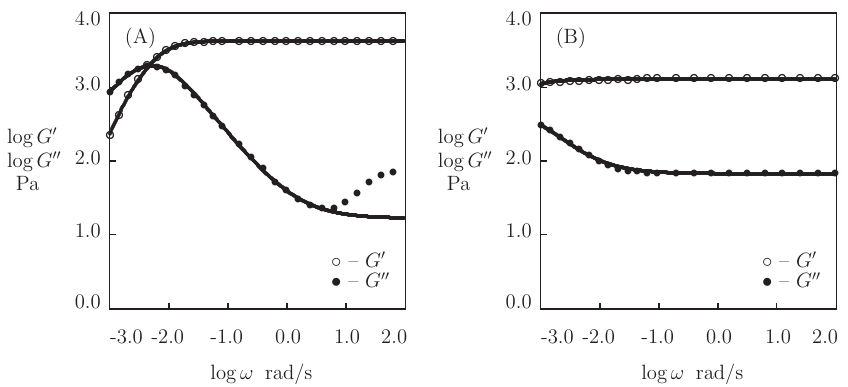
Figure 10. Storage modulus G (cid:48) and loss modulus G (cid:48)(cid:48) versus frequency ω . Symbols: experimental data [72] on protein gels PC 10 P ( A ) and PC 30 P ( B ). Solid lines: the results of